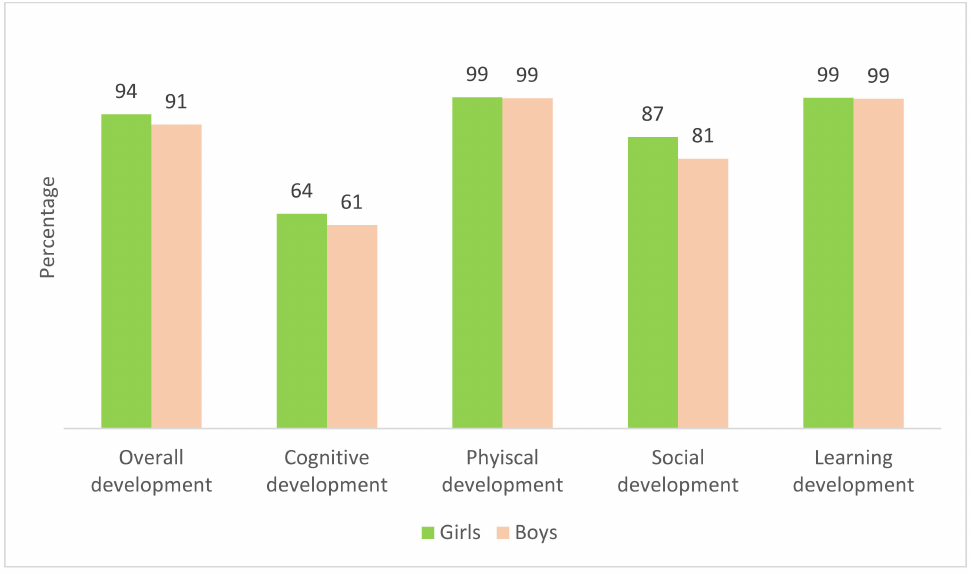
Figure 1. Percentage of children by gender who achieved appropriate ECD index by four domains.